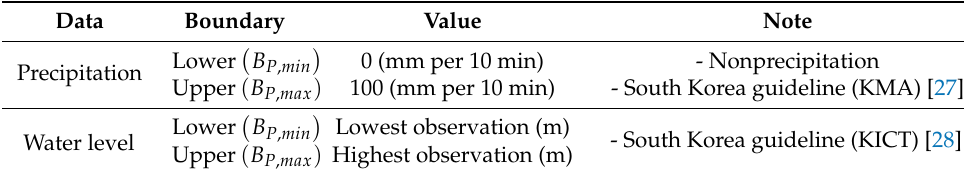
Table 1. Validation boundaries applied for physical check